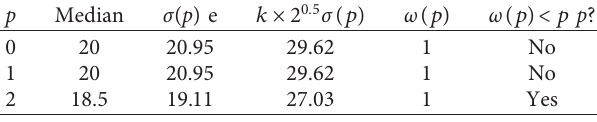
Table 11: step estimations for the investigation with the edge plan.